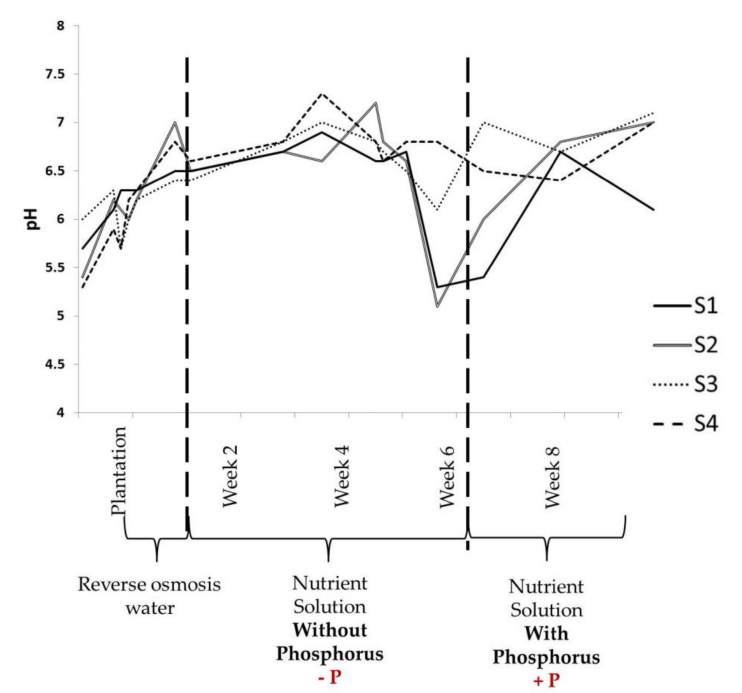
Figure 1. Evolution of pH value of the drainage water collected at the level of the different substrates (S1: 100% coconut fiber; S2: 66% coconut fiber + 33% bagasse; S3: 50% coconut fiber + 50% bagasse; S4: 33% coconut fiber + 66% bagasse) before planting and up to 10 weeks after planting.